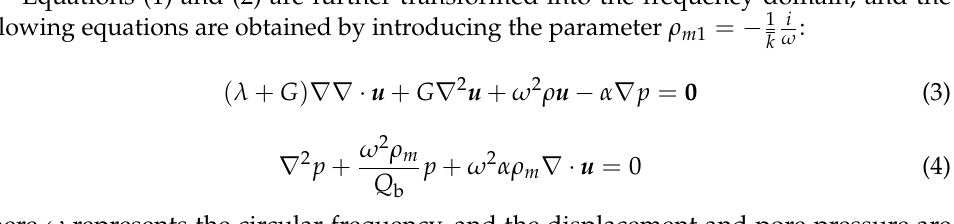
Figure 1. Schematic diagram of the wave in a saturated soil field under an interior point force. Equations (1) and (2) are further transformed into the frequency domain, and the